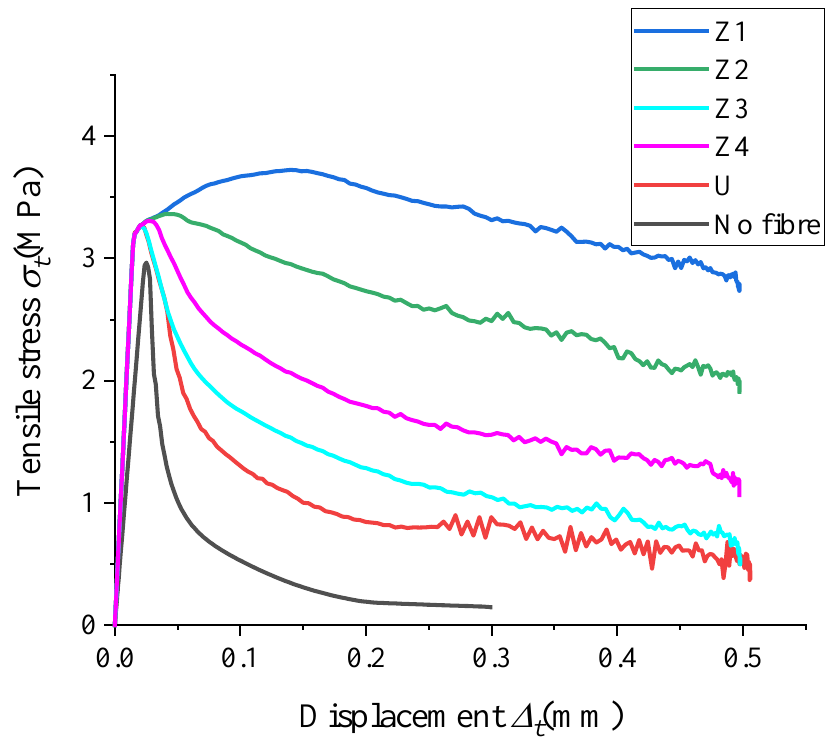
Figure 27. Tensile stress-displacement curves of SFRC models with different silane-coated fibres of random distribution under uniaxial tension.